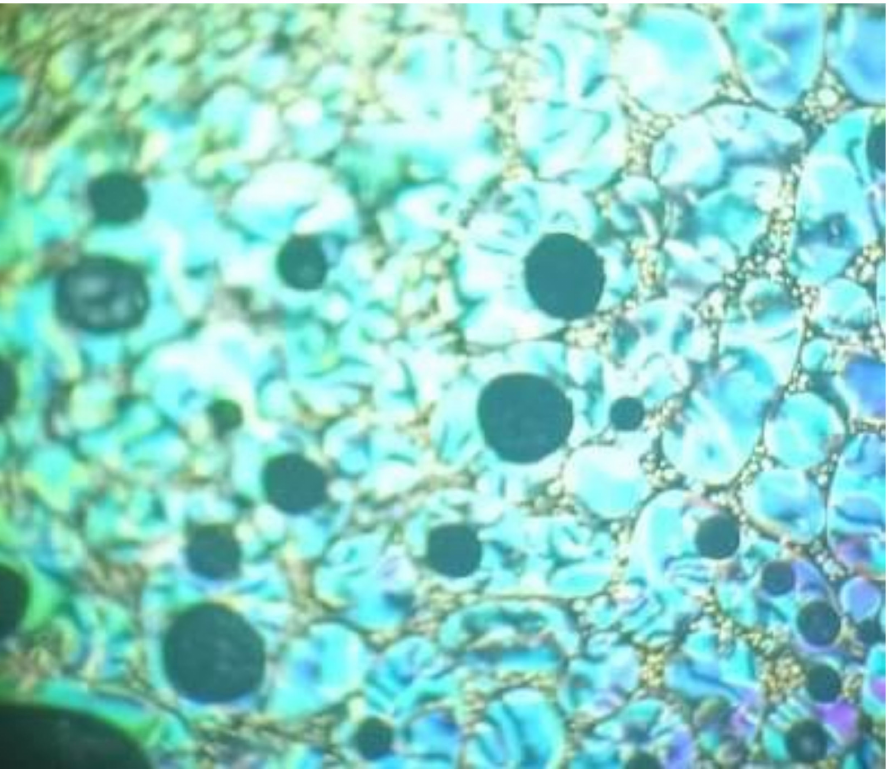
Figure 4. Nematic texture under polarized optical microscopy (POM) upon heating for I C 16 at 122 ◦ C, at 10.0 ◦